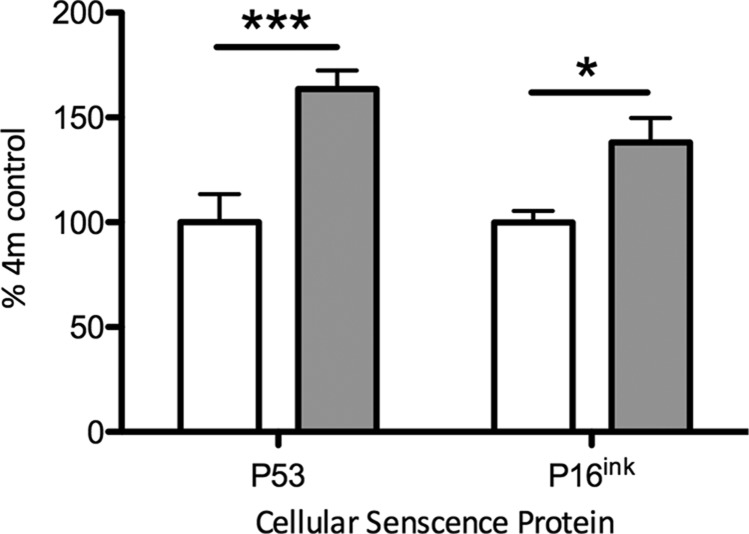
Effect of gestational hypoxia compared to normoxia on expression of cellular senescence proteins in the ovary. Data shown as means ± sem. Data are represented as the percentage of the 4-mo normoxia group (assigned baseline value of 100%). Open bars: normoxia (21% oxygen) during gestation; gray bars: hypoxia (13% oxygen) during gestation. P53, left; P16ink, right. ***P < 0.001, *P < 0.05.